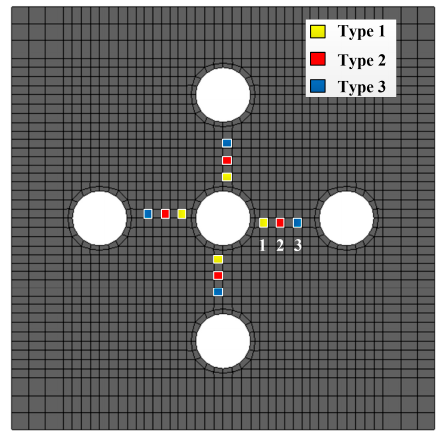
Figure 12. Sketch of typical elements.